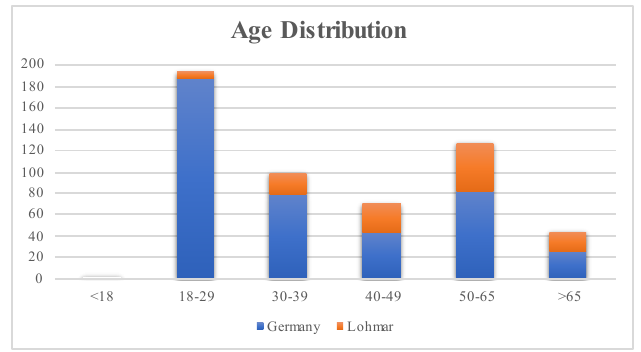
Figure 1. Age distribution for Germany and for Lohmar only.